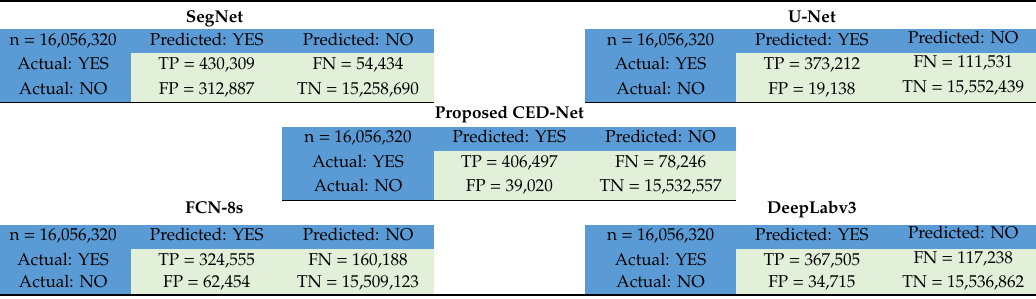
Table 8. Confusion matrices of SegNet, U-Net, FCN-8s, DeepLabv3, and proposed CED-Net for carrot crop and weed dataset.